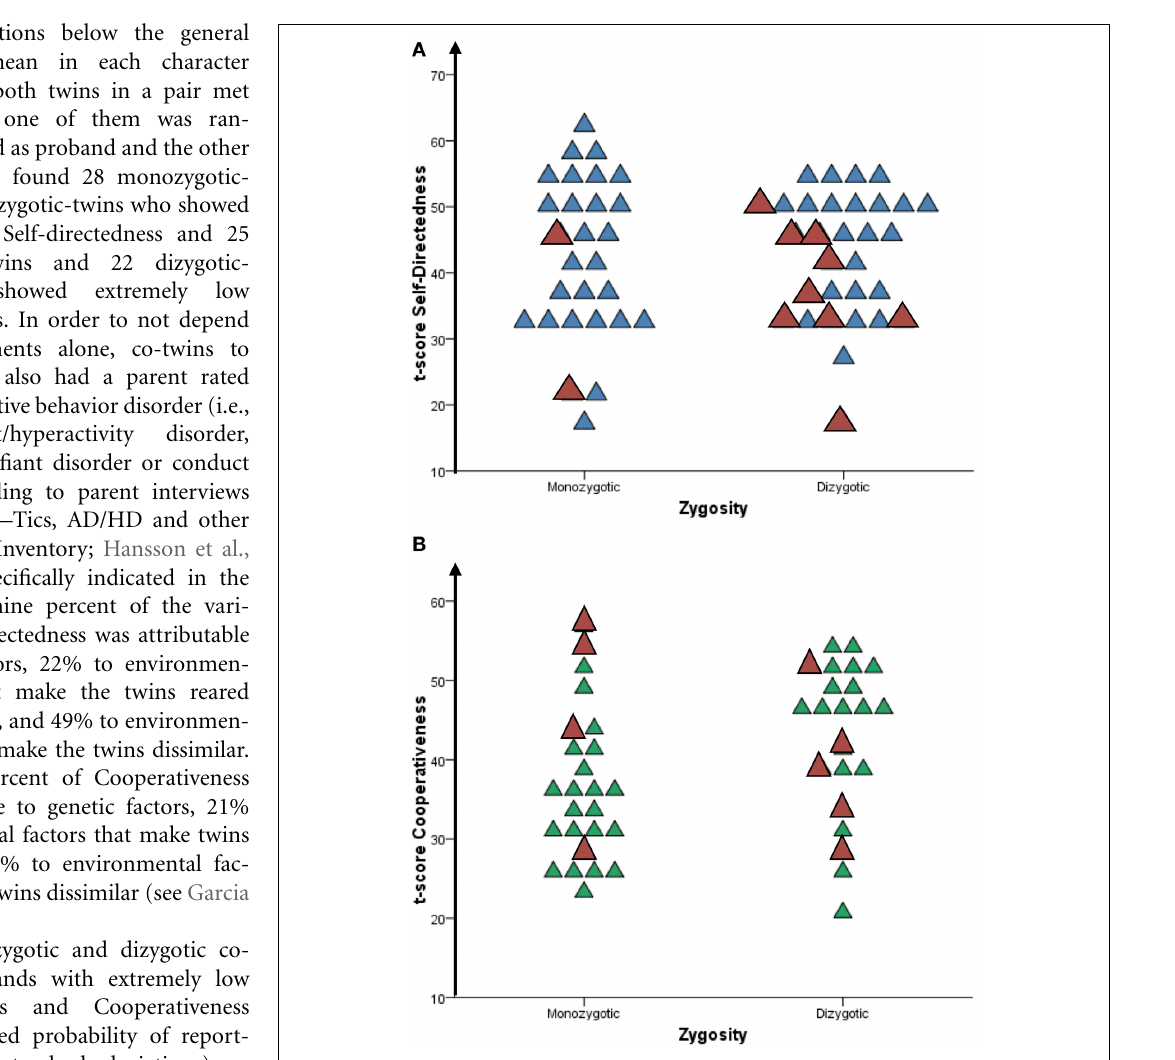
FIGURE 1 | (A) Distribution of Self-directedness ( t -scores) in monozygotic and dizygotic co-twins of adolescents with extremely low Self-directedness ( < 2 SD). (B) Distribution of Cooperativeness ( t -scores) in MZ and DZ co-twins of adolescents with extremely low Cooperativeness ( < 2 SD). Each triangle denotes one individual. = Co-twin has a disruptive behavior